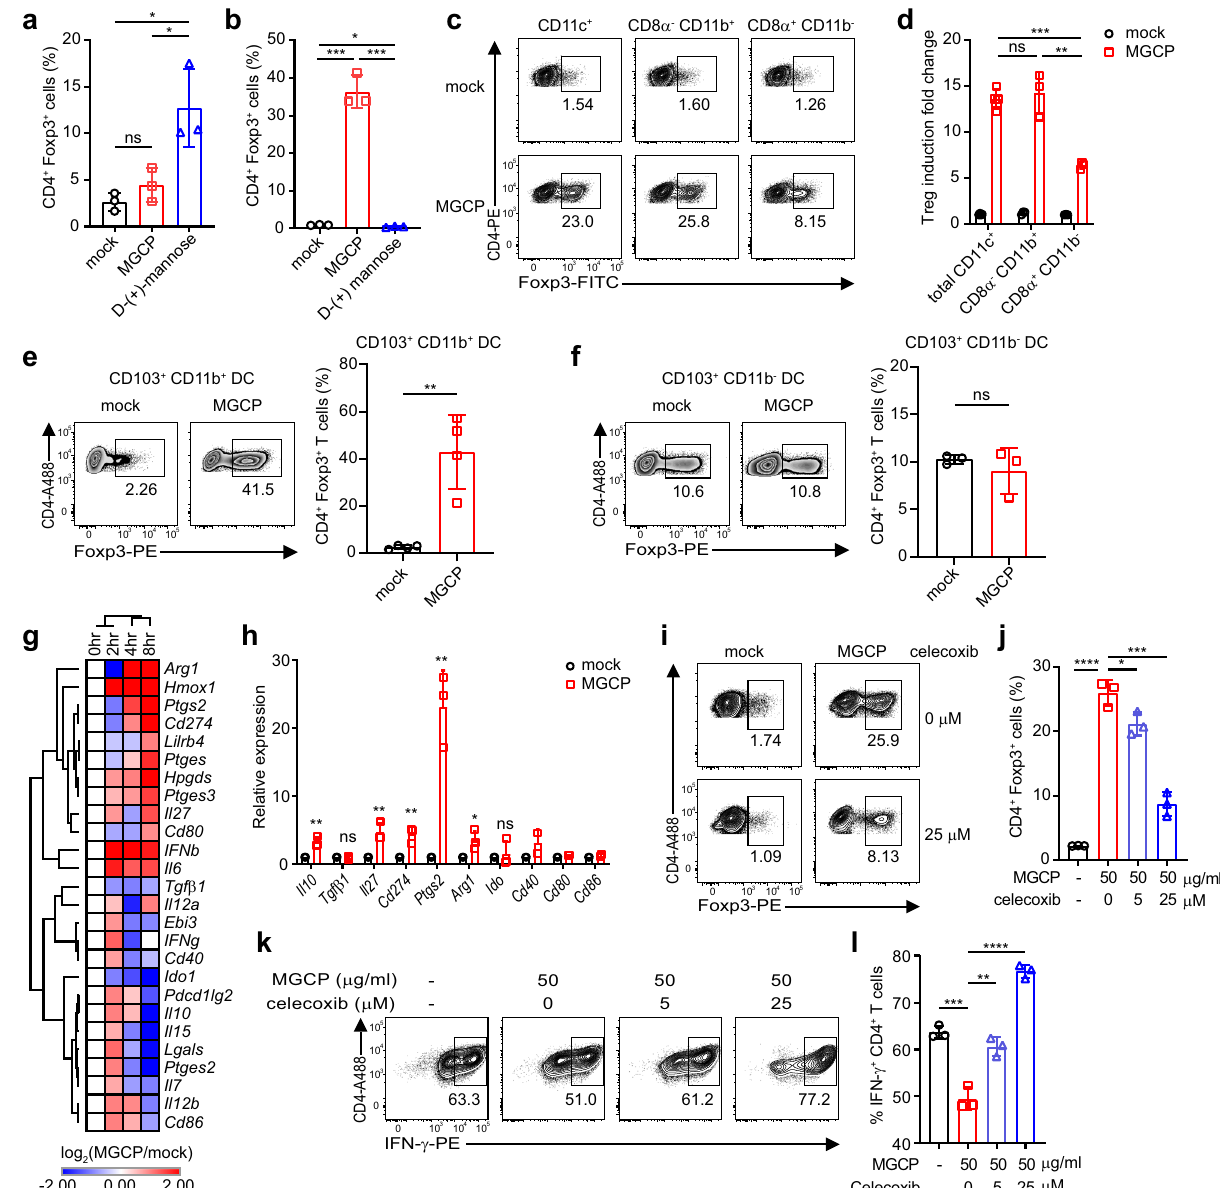
Fig. 6 MGCP-mediated immune regulation is dependent on Cox2. a Naive CD4 + T cells were cultured with either MGCP or D-( + )-mannose for 72 h in the presence of plate-coated anti-CD3 (1.5 µ g/ml), soluble anti-CD28 (1.5 µ g/ml), IL-2 (100 U/ml) and TGF- β 1 (2 ng/ml) and frequency of Treg cells induced were analyzed. Result is representative data with 3 samples over 2 independent experiments. b MGCP or D-( + )-mannose primed splenic DCs were cultured with naive CD4 + T cells under suboptimal Treg-inducing condition and frequency of Treg cells induced were analyzed. Result is representative data of 3 samples over 2 independent experiments. c – f Indicated DC subsets (MHCII + CD11c + ) were FACS sorted from spleen and small intestinal lamina propria (siLP), based on CD8 and CD11b (spleen) or CD103 and CD11b (siLP) expression, treated with MGCP or mock, and tested for their capability of inducing Treg cells under suboptimal iTreg inducing conditions. Representative FACS plots and relative frequencies of Treg cells induced by